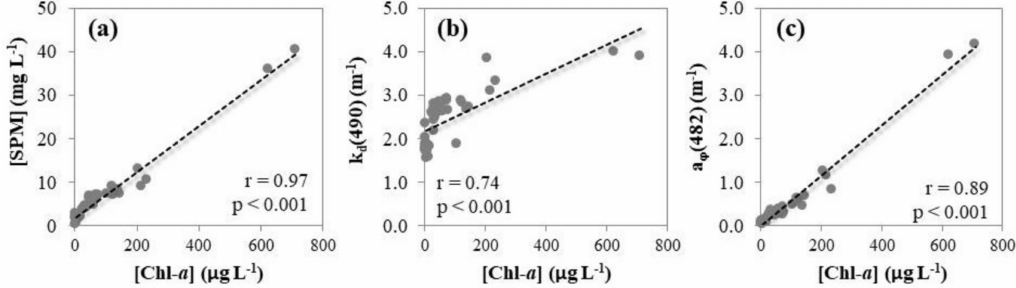
Figure 6. Relationships between [Chl- a ] and ( a ) [SPM]; ( b ) k d (490); and ( c ) a φ